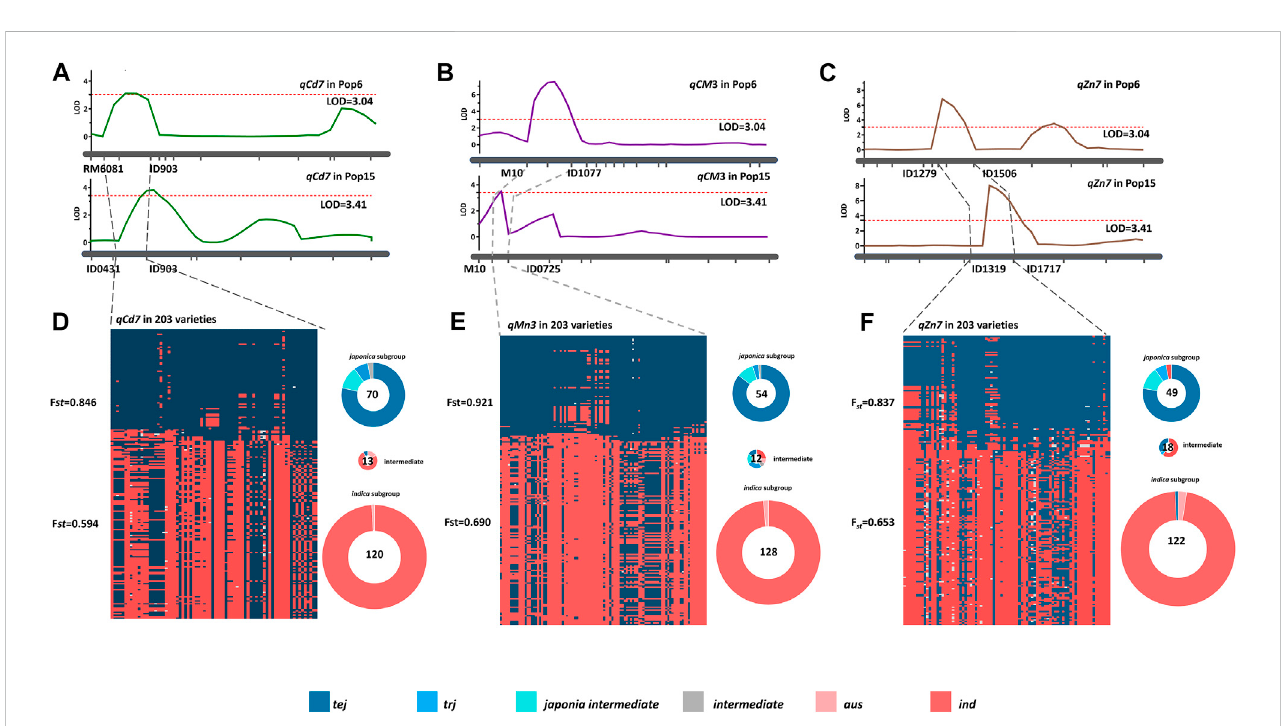
FIGURE 5 Three speci fi c QTLs detected from trj variety “ IRAT129 ” affecting the grain-Cd, grain-Mn, and grain-Zn accumulation in rice grain, and their subspecies divergence analysis. Genomic location of the QTLs (A) qCd7 , (B) qCM3 , and (C) qZn7 determined by QTL mapping of the two RIL populations. Subspecies divergence analysis of (D) qCd7 , (E) qCM3 ,and (F) qZn7 basedon theRiceVarMap2.0 database. The redand theblueplots represent thegenetic components ofthe indica and japonica varieties,respectively,whilethenumbersinthecirclesindicatethenumberof indica and japonica varietiesinthecollection.All theecotypes except aro ( ind , tej , trj , and aus )and theintermediates are indicated bydifferentcolors. The aro ecotype ismissing from theanalysisas it was not analyzed in the